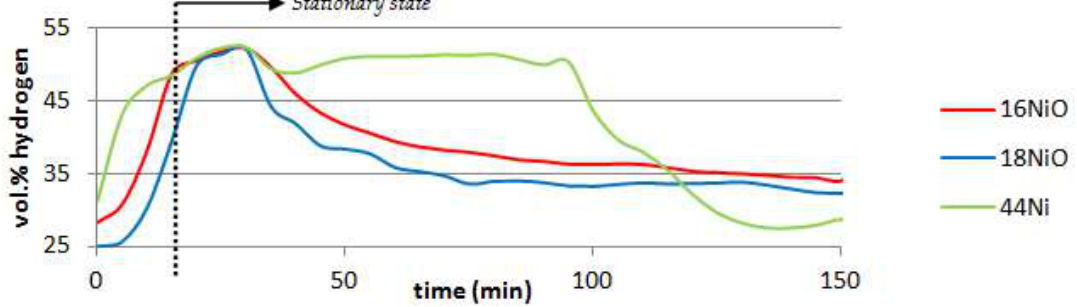
Figure 2. Hydrogen content of pyrolysis gases over time during the stationary state of the operation.